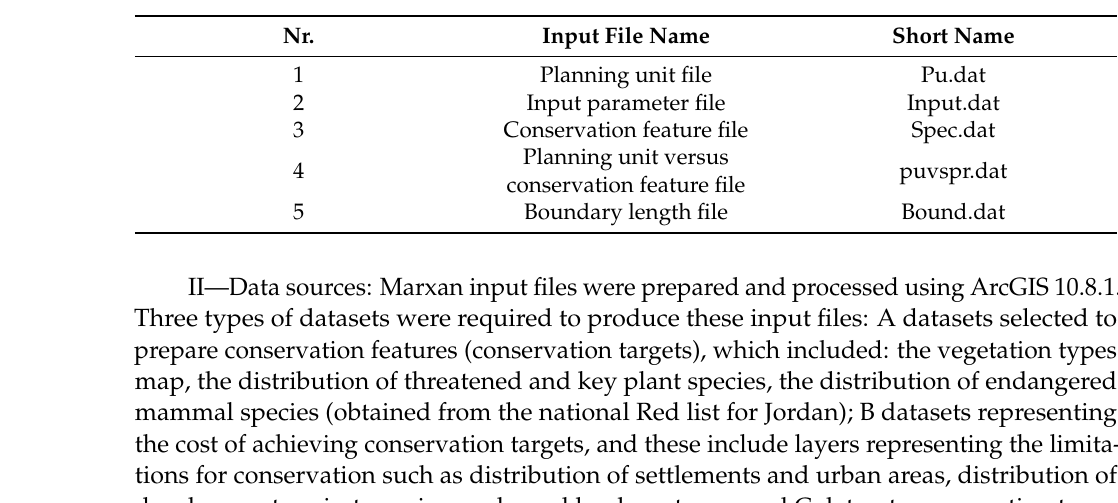
Table 4. Marxan input files, their default names